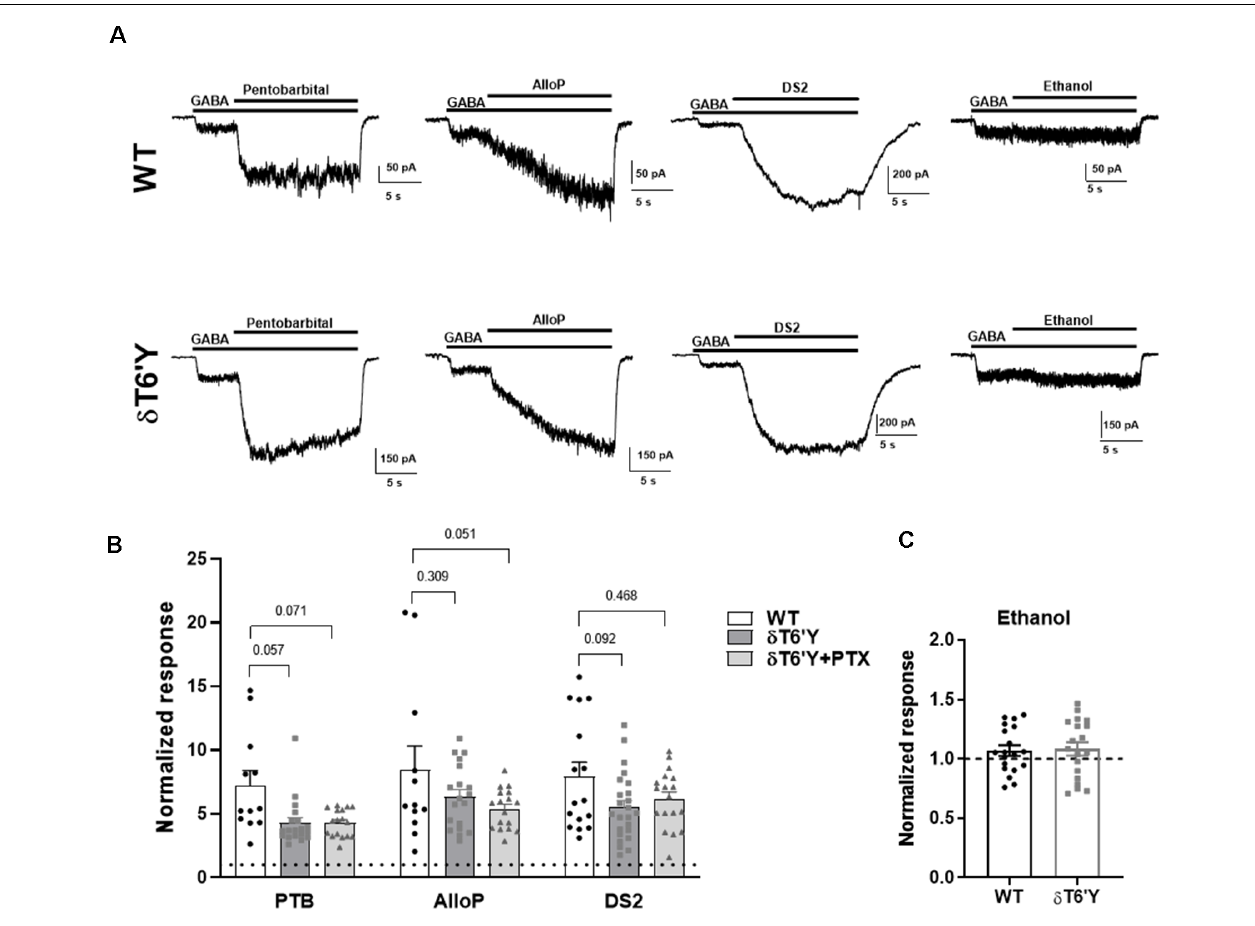
FIGURE 3 | PAM sensitivity in recombinant α 4 β 2 δ GABA A Rs expressed in N2a cells. (A) Example traces of response elicited from GABA (1 µ M) potentiated by pentobarbital (25 µ M) and AlloP (50 nM) in WT GABA A Rs, δ T6’Y GABA A Rs as indicated. (B) Summary of pentobarbital, AlloP and, DS2 effects on GABA current with 10 s application time ( n = 12–19) in WT δ and δ T6’Y containing receptors. Note that δ T6’Y in the presence of 50 µ M PTX is also represented. A two-way ANOVA showed a main effect of genotype ( F (2,145) = 10.04, p < 0.0001), with p-values for post hoc Sidak’s multiple comparison test given above the graphs. (C)